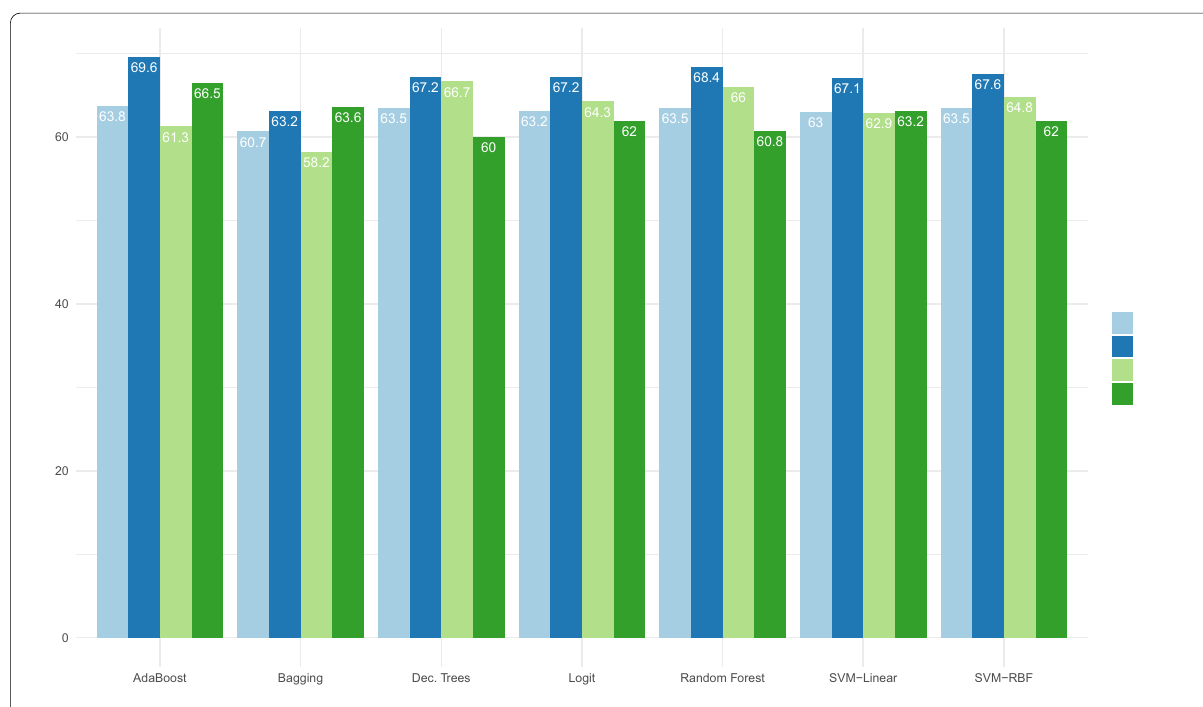
Fig. 2 Performance Measures (Accuracy in light blue, AUC in blue, Sensitivity in light green, and Specificity in green, respectively) for each technique, ordered by